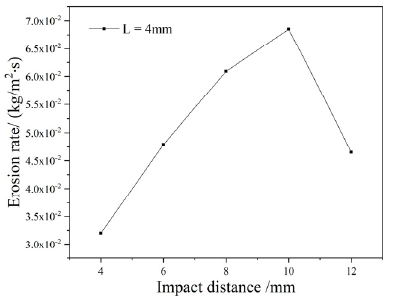
Figure 8. Influence curve with impact distance.